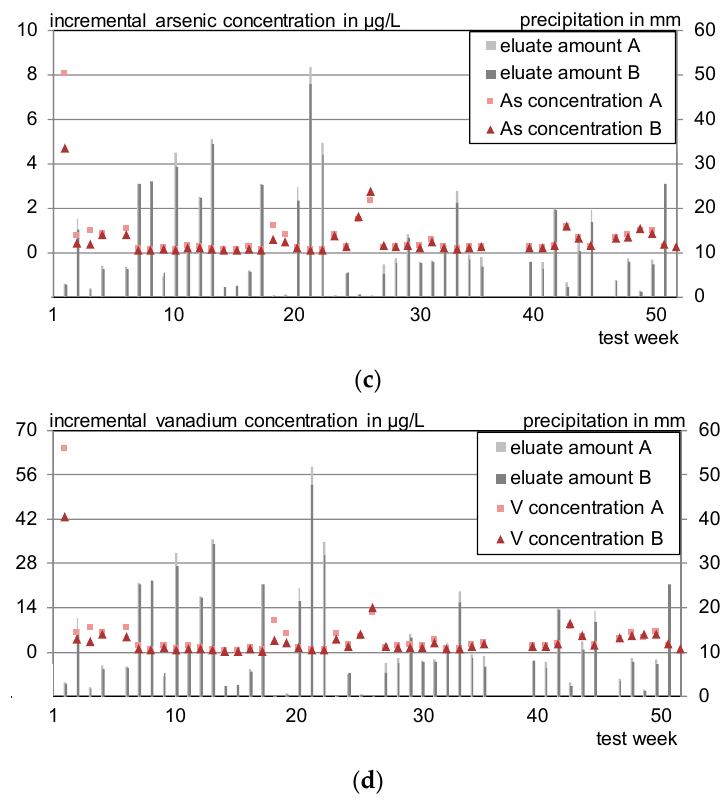
Figure 20. Incremental leachate concentrations of the test specimens F 1g. ( a ) Sodium; ( b ) calcium; ( c ) arsenic; ( d ) vanadium.